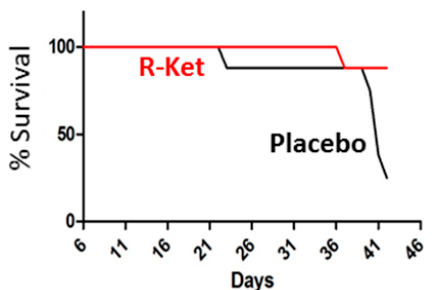
Figure 2. R-ketorolac improves survival in an in vivo xenograft model of ovarian cancer. OVCAR8 xenografts were established, then mice were treated with 10 mg / kg / day R-ketorolac or placebo by intraperitoneal injection for 6 weeks. The R-ketorolac group (R-Ket, red line) displayed improved survival compared to the placebo (black line) group (88% survival versus 25% survival). One mouse in the R-ketorolac group was lost at 37 days of treatment. For the placebo control group, mice were lost at day 23 (1), day 40 (1), day 41 (3), and day 42 (1, study termination). There was a statistically significant di ff erence ( p -value ≤ 0.0142) in survival between the placebo and R-ketorolac treatment groups, as determined using the Kaplan–Meier method and comparisons using the log-rank test. N = 8 mice/group.